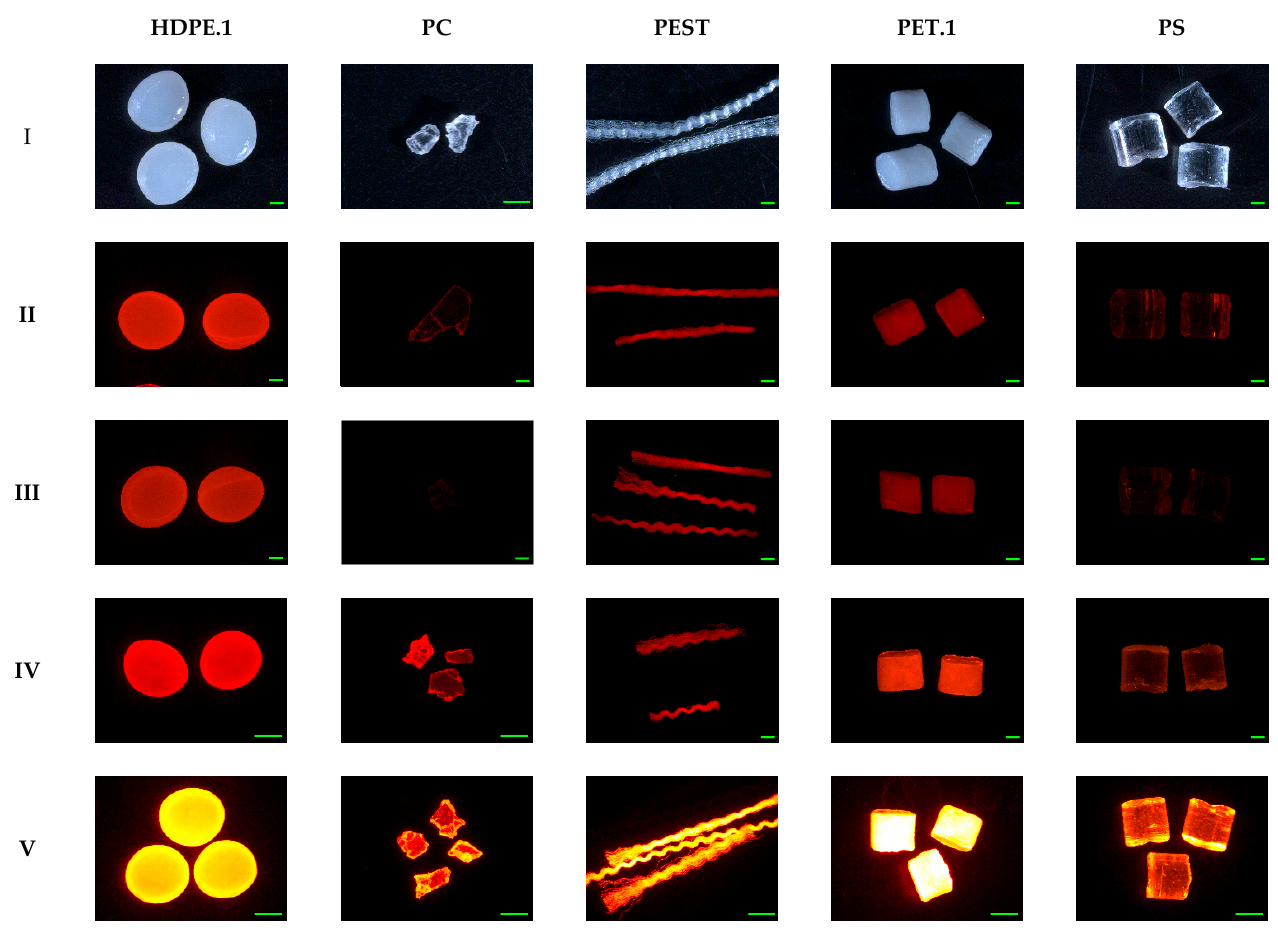
Figure 3. Fluorescence microscope images of ( I ) original color of polymers, ( II ) polymers stained by 55 mg/mL Rit pink dye, ( III ) polymers stained by 5 mg/mL iDye pink dye, ( IV ) polymers stained by 2 µg/mL methanol-based Nile red, and ( V ) polymers stained by 2 µg/mL water-based Nile red at 70 °C for 3 h. Scale bar denotes 1 mm.